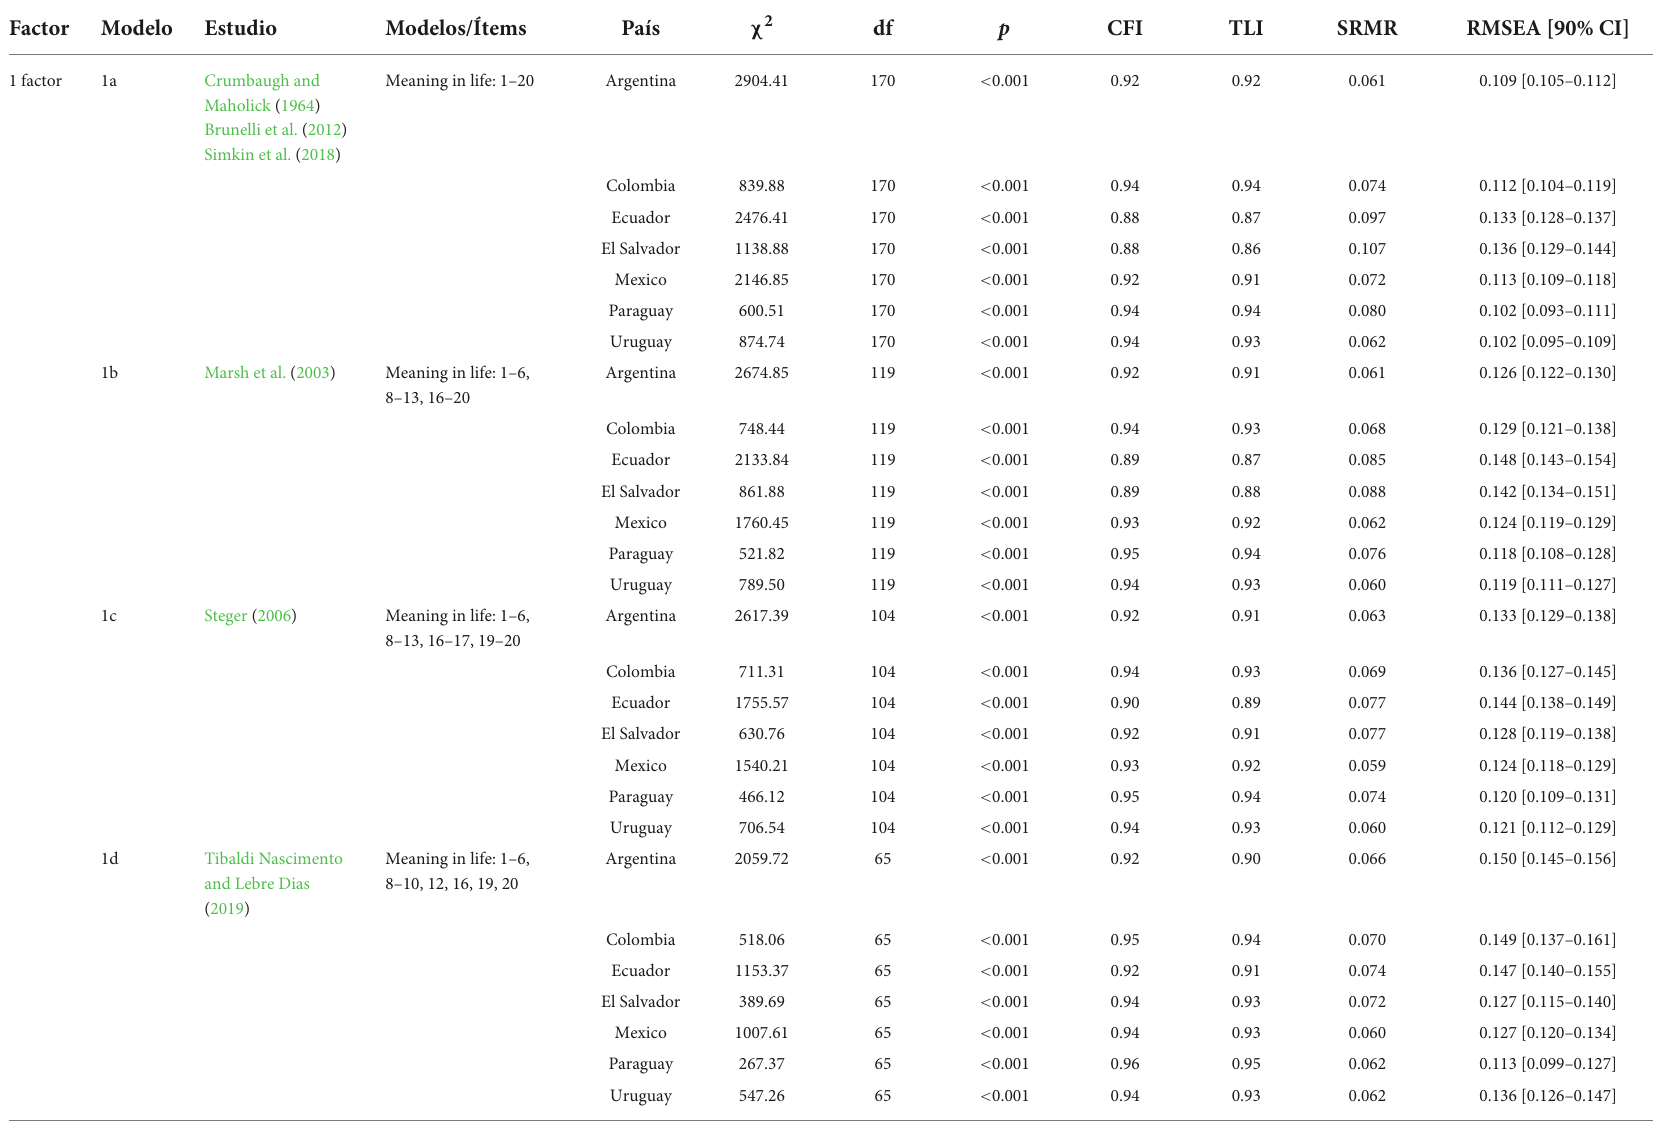
TABLE 2 Fit indices, factorial weights and reliability of the models by country of participants.